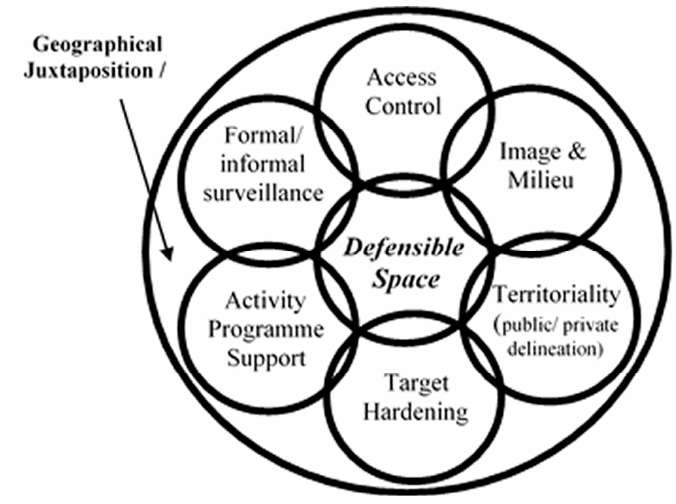
Figure 2. Cozens’ Defensible Space Model (2001) and reference to geographical juxtaposition.